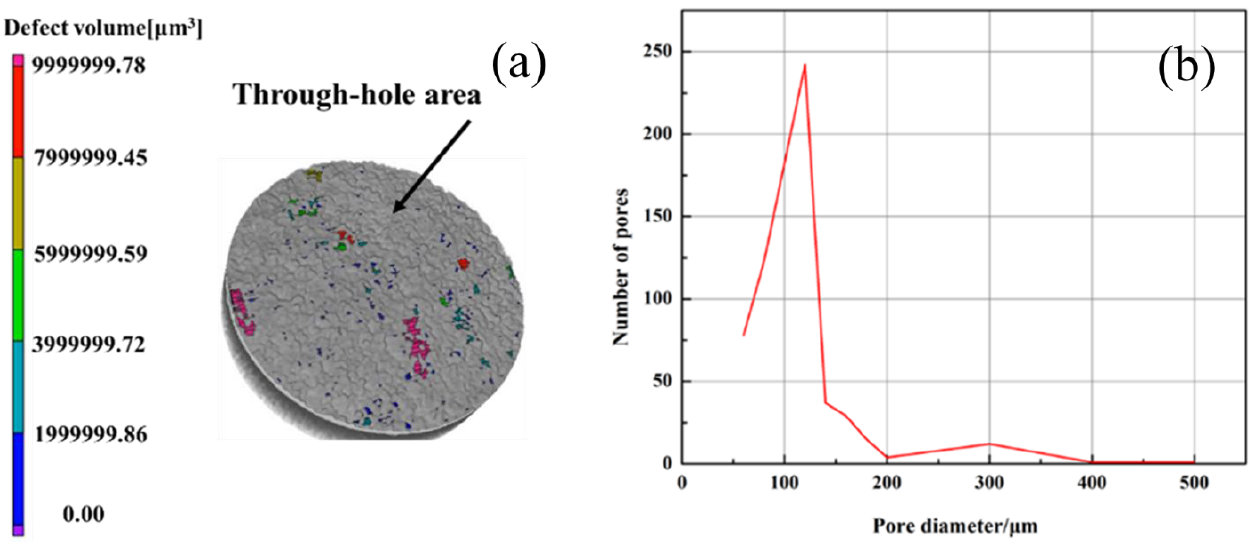
Figure 6. Industrial computed tomography of coating: ( a ) the pore distribution of the coating, ( b ) the statistics of pore diameter of coating. Table 2. Thickness, porosity, and surface roughness of the coating.